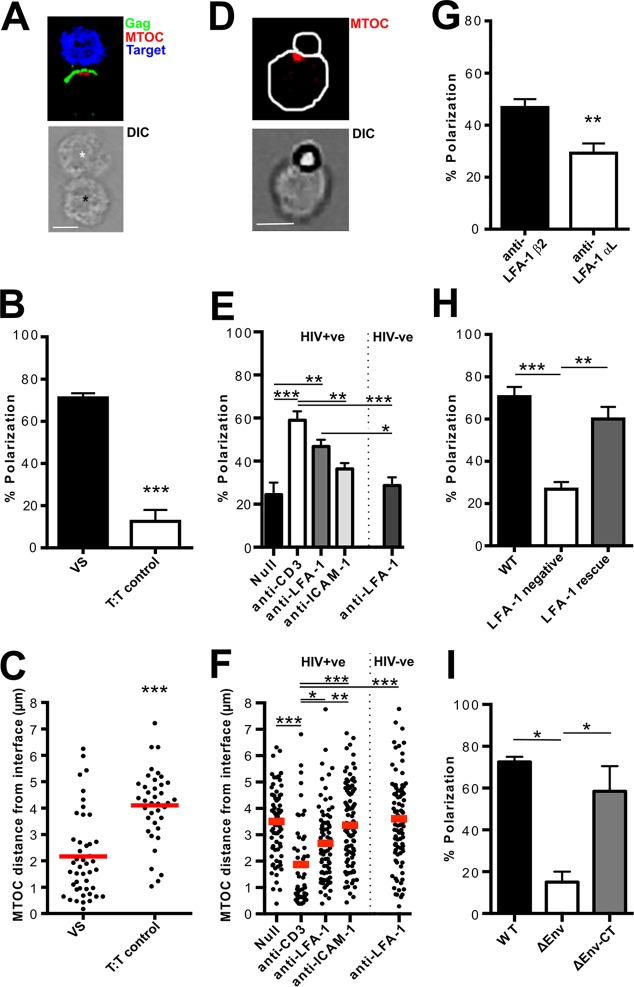
LFA-1 engagement is sufficient to trigger MTOC polarization in HIV-1-infected cells. (A) Using IF analysis, doublets formed from one HIV-1-infected cell (Gag [green] positive; black asterisk) and one uninfected T cell (blue; white asterisk) that showed polarization of Gag to the contact site were identified as VS. The MTOC (γ-tubulin; red) was scored as polarized if it was aligned at the interface-proximal third of the HIV-1-infected cell. DIC, differential interference contrast. (B) Quantification of the percentages of contacts with a polarized MTOC in VS (n = 45) and uninfected target-target (T:T) control contacts (n = 40). (C) Distance of the MTOC from the cell contact site in VS (n = 45) and T-T contacts (n = 38). (D) Representative image of an HIV-1-infected Jurkat T cell conjugated with an antibody-coupled bead and stained for the MTOC (γ-tubulin; red). (E) Beads with no antibody (negative control [Null]; n = 91) or coupled with anti-CD3 (positive control; n = 106), anti-LFA-1 β2 subunit (n = 193), or anti-ICAM-1 (n = 158) were mixed with HIV-1-infected T cells (HIV+ve) or uninfected T cells (HIV-ve), mixed with anti-LFA-1 beads (n = 190), and incubated for 60 min. Contacts were scored as polarized if the MTOC fell within the bead-proximal third of the cell. (F) Distance of the MTOC from the cell-bead contact site. (G) As in panel E, but using HIV-1-infected Jurkat cells mixed with beads specific for the LFA-1-β2 subunit (n = 193) or αL subunit (n = 109). (H) Quantification of MTOC polarization in HIV-1-infected mutant or WT Jurkat cells engaged in a VS with an uninfected target T cell. WT Jurkat cells, n = 30; LFA-1-negative Jurkat cells, n = 30; LFA-1-reconstituted Jurkat cells, n = 30. (I) Quantification of MTOC polarization in T cells infected with either WT, ΔEnv, or ΔEnv-CT HIV-1 engaged in contact with an uninfected target T cell. *, P < 0.05; **, P < 0.01; ***, P < 0.001 (three independent experiments). (A and D) Scale bars, 5 μm. The error bars represent SEM. Horizontal bars show the mean.